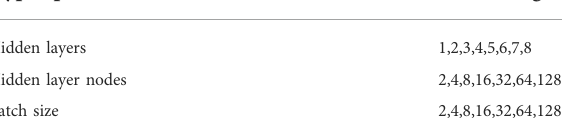
TABLE 3 Value range of